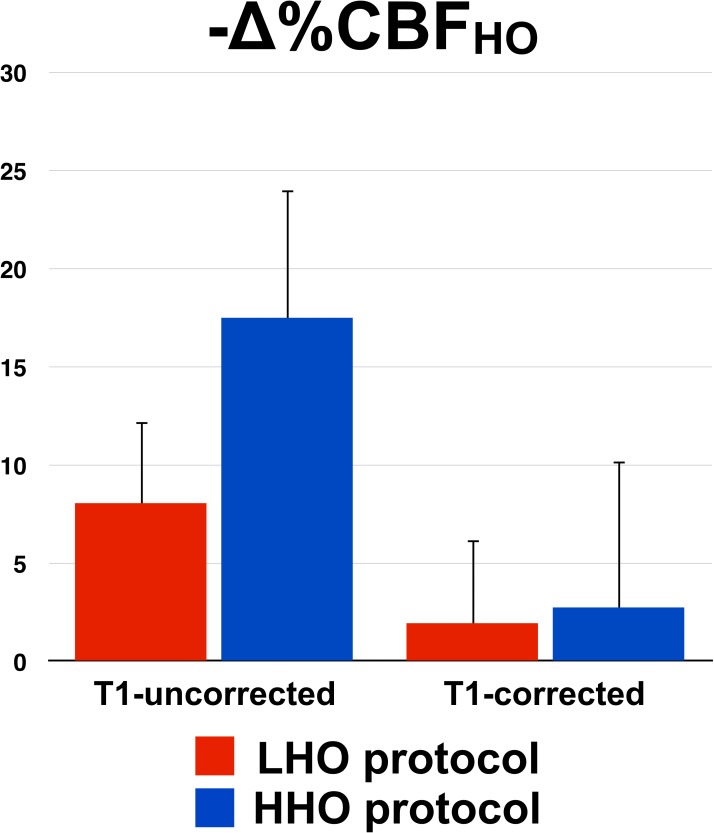
T1 shortening.For each protocol, pre- and post-T1-correction CBF changes during HO, averaged across tests, are presented with the standard deviation as error bars.